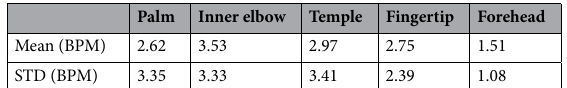
Table 3. HR estimation performance at peripheral body